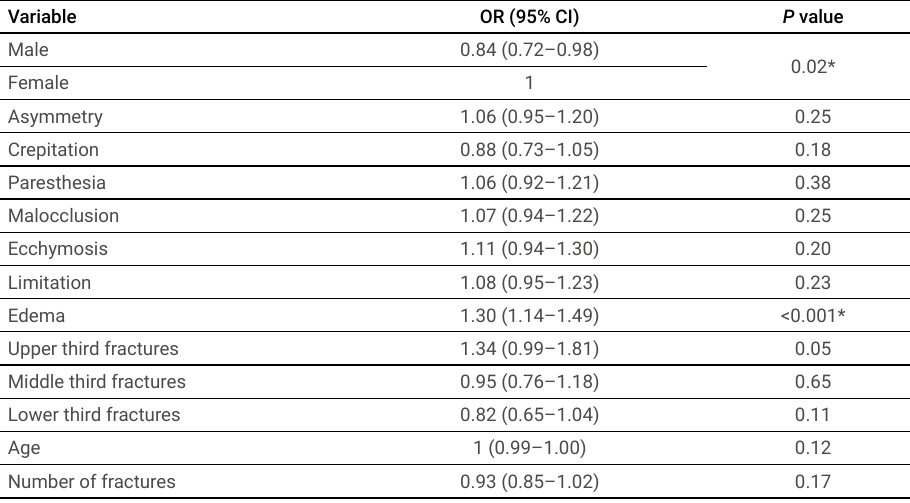
Table 7. Generalized linear model showing predictors for the time of hospital discharge, which was used as a dependent variable.